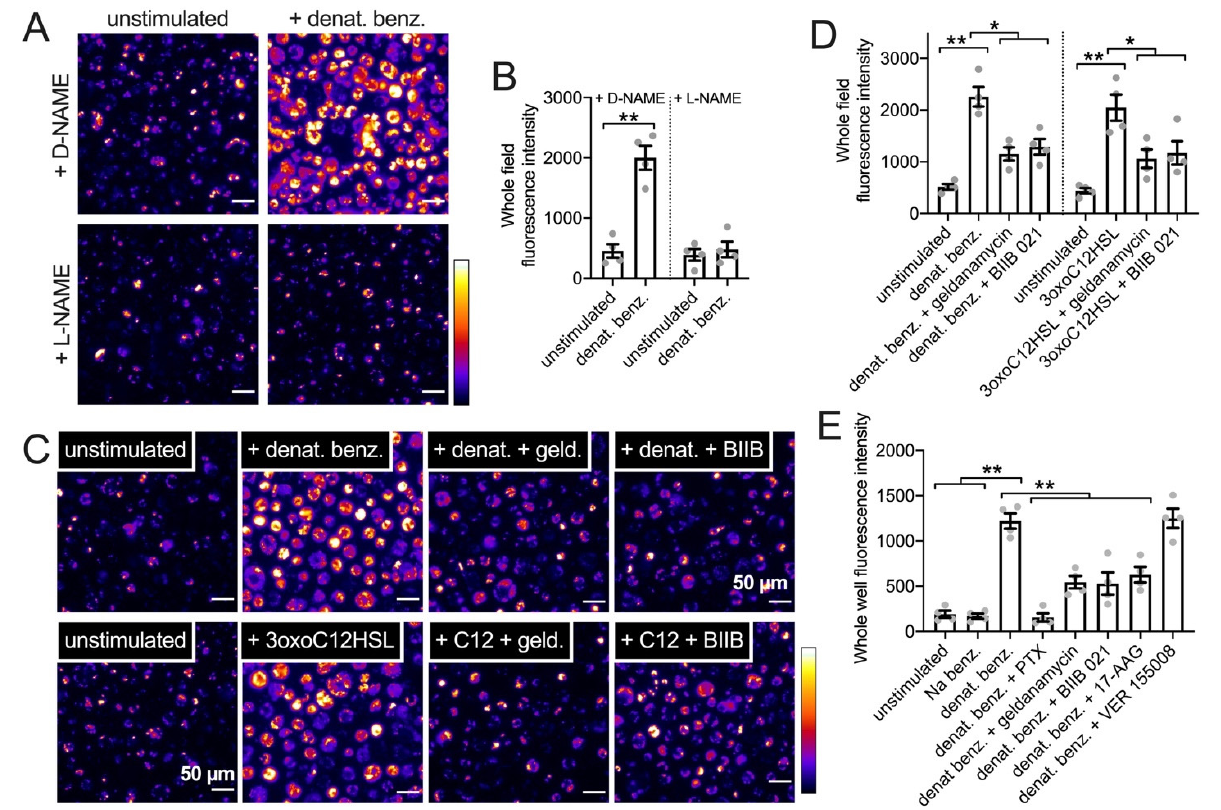
Figure 11. HSP90 inhibition reduces T2R-stimulated pHrodo- S. aureus phagocytic responses in primary human M0 M Φ s. ( A ): Representative images of pHrodo-labeled S. aureus phagocytosis in primary human M Φ s ± denatonium benzoate (1 mM) stimulation after D-NAME or L-NAME pretreatment (10 µM; 45 min). ( B ) : Bar graph of pHrodo- S. aureus fluorescence after experiments as in A . Significance by Bonferroni post-test with paired comparisons; ** p < 0.01. ( C ): Representative images of pHrodo-labeled S. aureus phagocytosis in primary human M Φ s ± denatonium benzoate (1 mM) or 3oxoC12HSL (100 µM) after no-pretreatment (0.1% DMSO only as vehicle control)) or pretreatment with HSP90 inhibitors geldanamycin or BIIB 021 (pretreatment as in Figure 8). ( D ): Bar graph of pHrodo- S. aureus phagocytosis during stimulation with HBSS only (unstimulated control), 1 mM denatonium benzoate, or 100 µM 3oxoC12HSL ± geldanamycin or BIIB 021 (pretreatment as in Fig- ure 9). Significance by one-way ANOVA with Bonferroni post-test; * p < 0.05 or ** p < 0.01. ( E ): Bar graph of pHrodo- S. aureus phagocytosis during stimulation with HBSS only (unstimulated control) or 1 mM denatonium benzoate ± pertussis toxin (PTX), geldanamycin, BIIB 021, 17-AAG, or VER 15508. PTX (500 ng/mL) pretreatment was 18 h. M Φ s were pretreated with other inhibitors as in Figure 9. Significance by one-way ANOVA with Bonferroni post-test; ** p < 0.01.